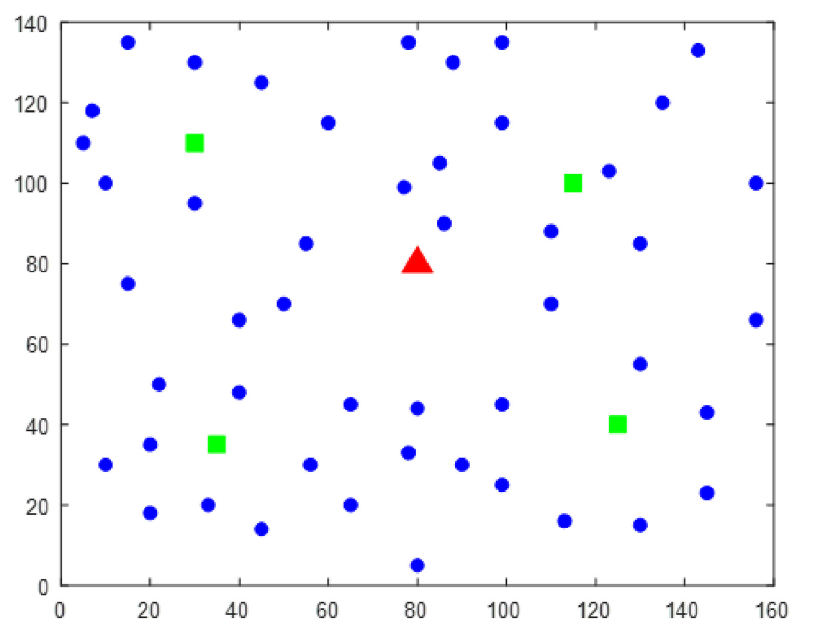
Fig 4. Location map of logistics distribution system.